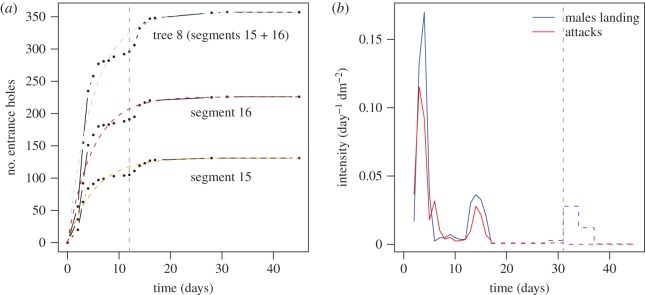
Infestation dynamics. (a) Typical colonization dynamics, here on tree 8 and its segments (basal no. 15 and upper no. 16). Black dots, observed points; dashed lines, nonlinear fit (blue, entire tree 8; orange, segment 15; red, segment 16); vertical grey dashed line, beginning of the second colonization stage. (b) The time series of daily male landing intensity (sum of the four traps) and the daily appearance of new entrance holes on the segments (sum of the 13 segments) are well correlated. Daily intensities are computed as intensityLand = (no. landing per day × SR)/area traps and intensityHole = no. new holes per day/total segments area. The grey vertical dashed line indicates the 31st day of the experiment, when a third landing wave (or at least partly a wave of re-emerging beetles caught in the landing traps) was observed without any additional entrance holes on the segments. The dashed red and blue lines indicate mean values computed from an intercensus duration greater than 1 day.